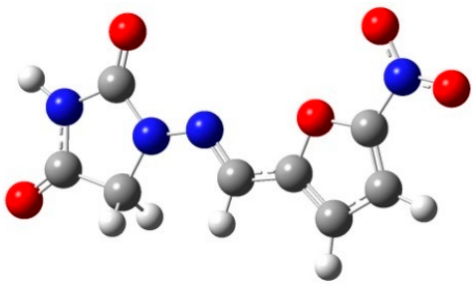
Figure 1. Molecular structure of nitrofurantoin (NF).